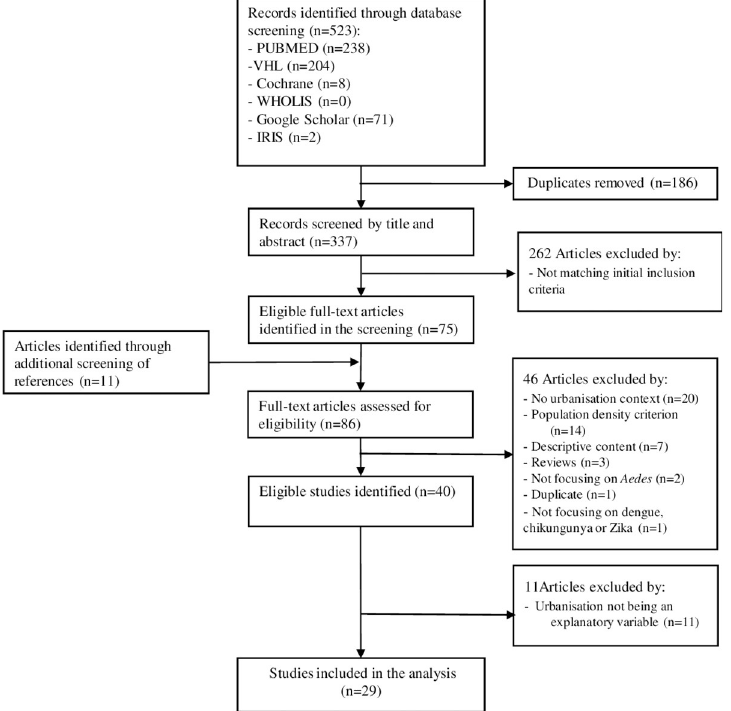
Fig 1. PRISMA flow diagram. I AU : AnabbreviationlisthasbeencompiledforthoseusedthroughoutFig 1 : Pleaseverifythatallentriesarecorrect : RIS, Institutional Repository for Information Sharing; PRISMA, Preferred Reporting Items for Systematic Reviews and Meta-Analyses; VHL, Virtual Health Library; WHOLIS, WHO Library Database.